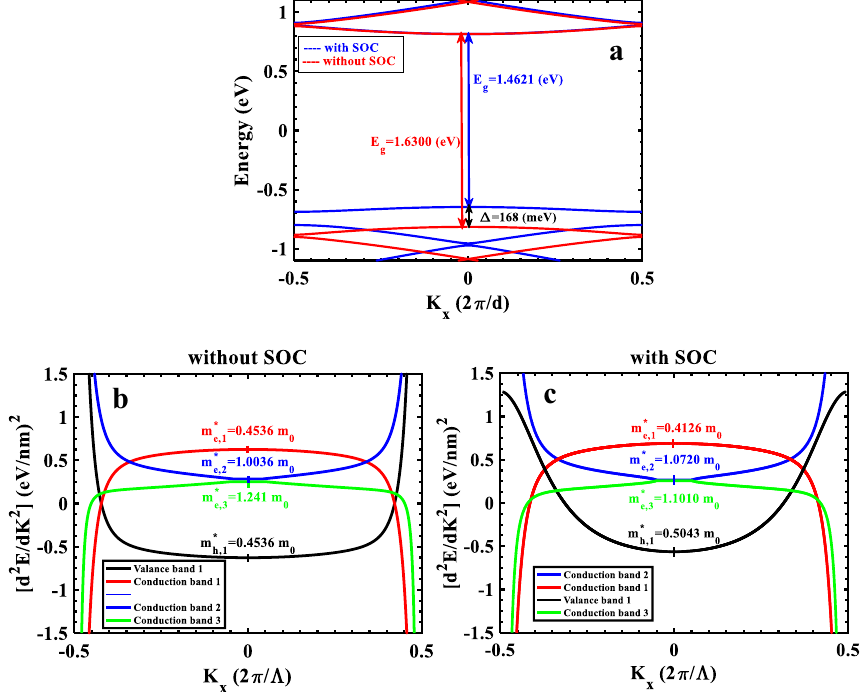
Figure 2. ( a ) Comparison of the band structures for two cases: with and without SOC; ( b , c ) the second derivative of the band structure, and the relevant effective masses around the point K = 0, without SOC and with SOC, respectively